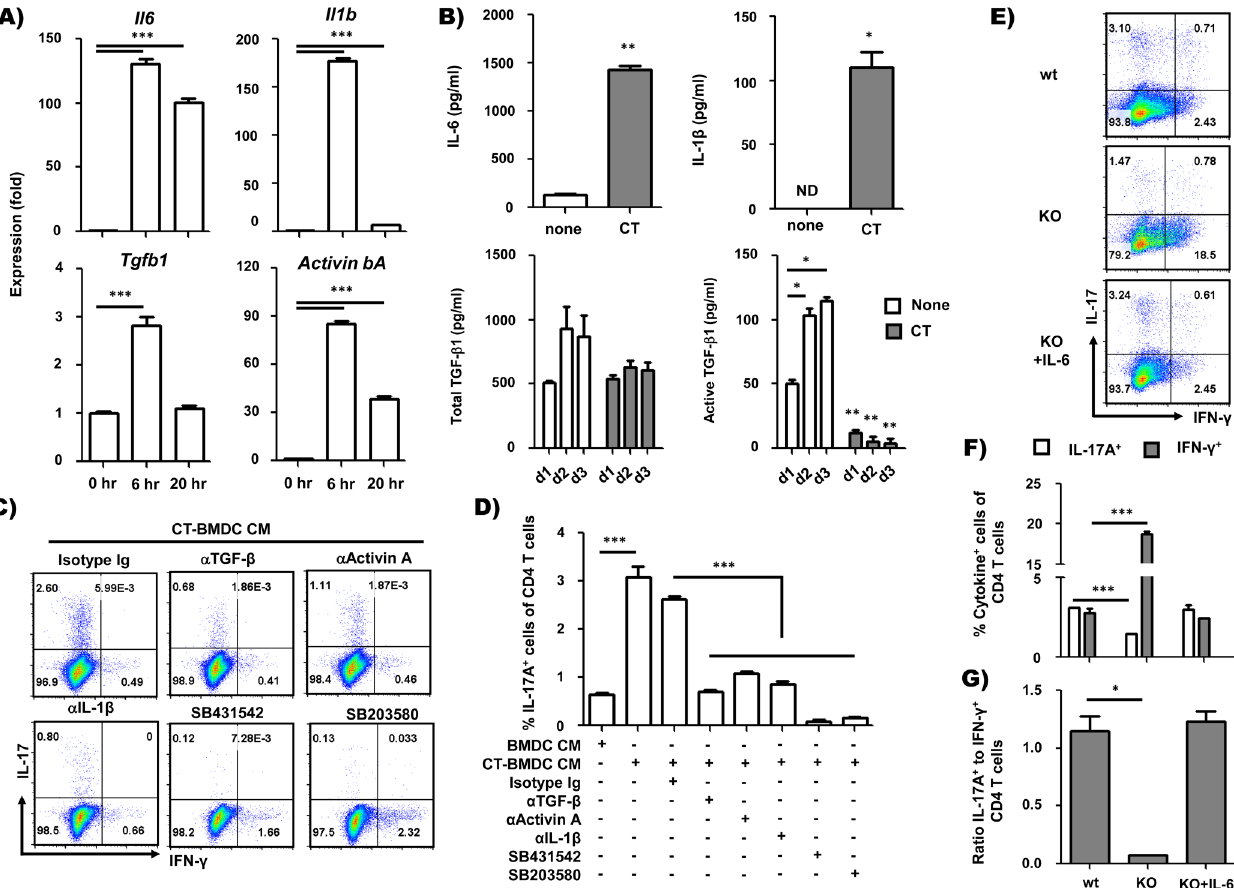
Fig 5. CT – treated BMDCs mediate Th17 cell differentiation by producing Th17 polarizing cytokines. (A) RT-PCR analysis of IL-6, IL-1 β , TGF- β 1 and activin A mRNA in BMDCs. BMDCs were cultured with CT (2 μ g/ml) and harvested at 0, 6, or 20 h after CT treatment. mRNA levels of IL-6, IL-1 β , TGF- β 1 and activin β A were normalized by mRNA expression of GAPDH and β -actin. (B) Determination of cytokines in BMDC- conditioned media. BMDCs were cultured with CT (2 μ g/ml) for 2 days, and culture media was removed to measure cytokines. IL-6 and IL-1 β were assayed by multiplex bead cytokine assay kit following the manufacturer ’ s recommended protocol (eBioscience). TGF- β 1 in BMDC- conditioned media was assayed for total (left) and active form (right) by ELISA (R&D Systems). (C and D) Intracellular staining of IFN- γ and IL- 17A in OT-II CD4 + T cells stimulated with anti-CD3 and anti-CD28 antibody in the presence of BMDC-CM or CT-BMDC-CM for 5 days and restimulated with PMA and ionomycin after 5 days. Neutralizing antibodies and kinase inhibitors were also added in the culture as indicated. (E-G) BMDCs from IL-6 -/- mice were used for clarifying a role of IL-6 in Th17 differentiation promoted by CT-treated BMDCs. Frequency of IFN- γ + or IL-17A + CD4 + T cells (F) and ratio of IL-17 + cells to IFN- γ + cells (G). * p < 0.5, ** p < 0.01, *** p < 0.001 (Student ’ s t -test). Data are the representative of at least two independent experiments with similar results and average ± SEM of triplicate wells in A and D or duplicate wells in B, F and G.